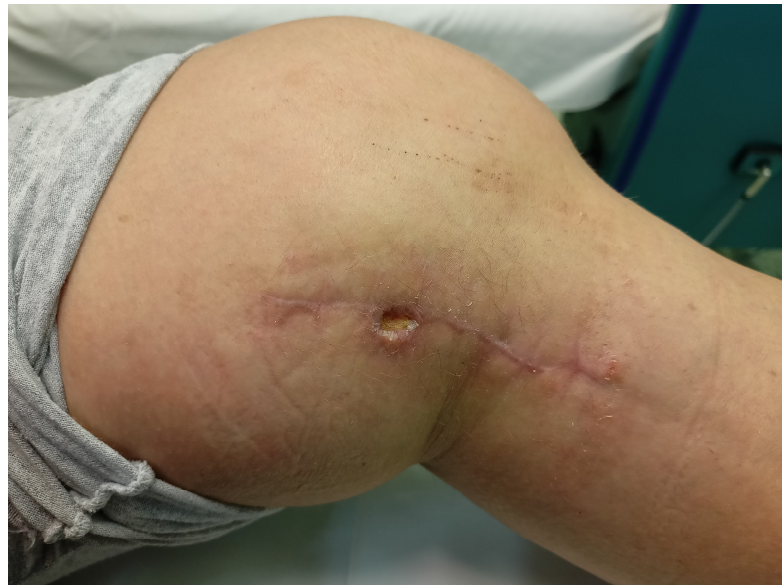
Figure 2. The local state of the wound after 10 topical ozone therapy procedures.